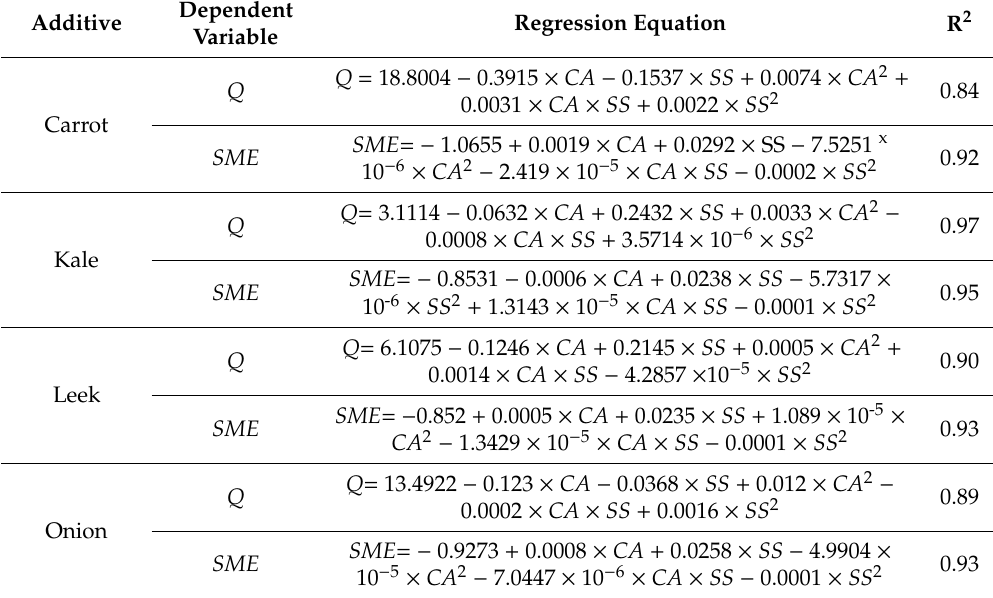
and specific energy consumption during the extrusion-cooking.